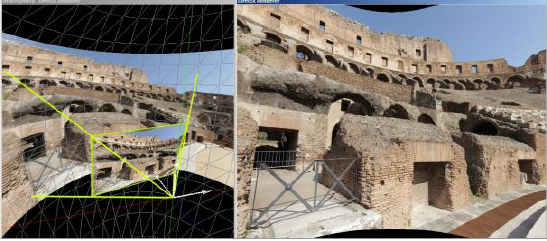
Figure 8. Acquisition of high resolution planar projections